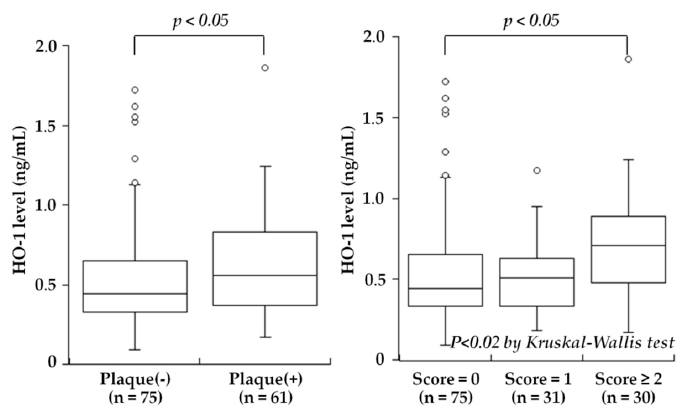
Figure 1. Plasma HO-1 levels and the presence of carotid plaque or the plaque score. Plasma HO-1 levels were significantly higher in subjects with carotid plaque than in those without plaque ( p < 0.05) ( left ). A stepwise increase in HO-1 levels was found depending on the plaque score: 0.44 ng / mL in subjects with score = 0, 0.51 ng / mL in score = 1, and 0.70 ng / mL in score ≥ 2 ( p < 0.02). HO-1 levels in score ≥ 2 were higher than those in score = 0 ( p < 0.05) ( right ). The central line represents the median, and the box represents the 25th to 75th percentiles. The whiskers represent the lowest and highest value in the 25th percentile minus 1.5 IQR and 75th percentile plus 1.5 IQR, respectively. (Modified from Kishimoto et al. [25]).